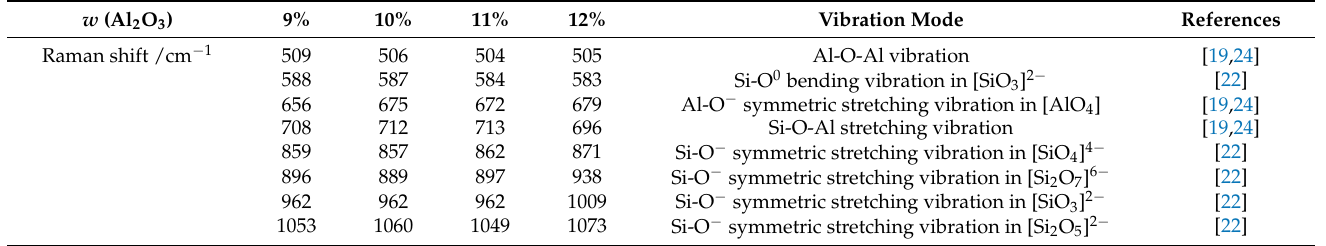
Figure 11. Raman spectra of glassy phase samples with different Al 2 O 3 contents. Table 6. Glassy phase characteristic peak positions and reference data for different Al 2 O 3 contents.